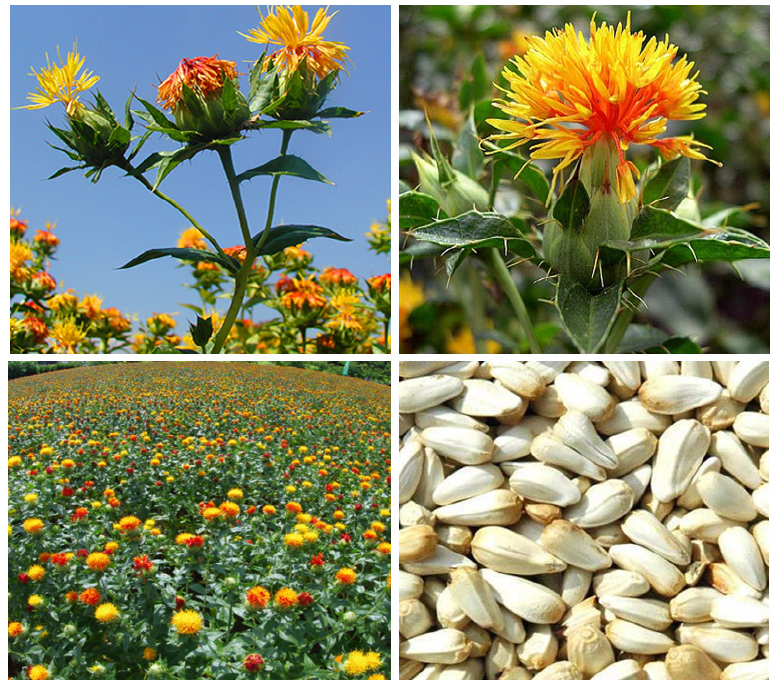
Figure 1. A comprehensive perspective; safflower plants, its flowers, fields and seeds